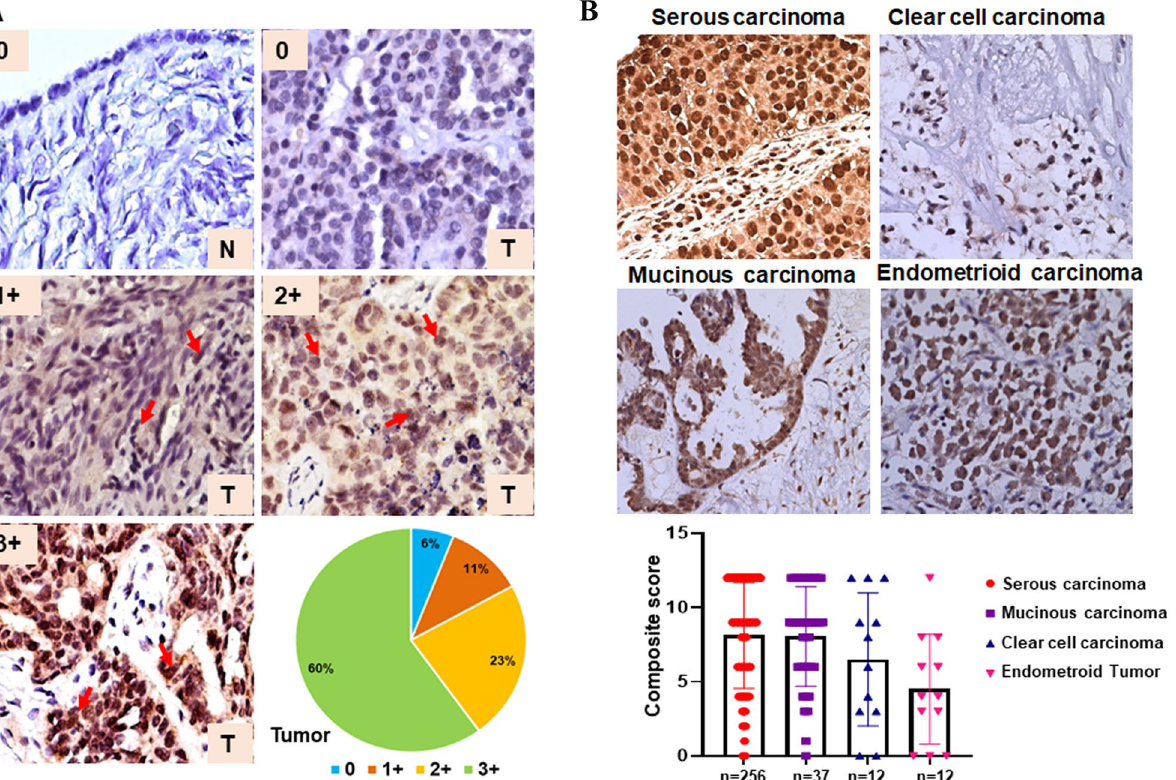
Figure 1. MYB protein expression in the cohort of ovarian cancer. ( A ) MYB expression in normal (N) ovary (n = 23) and tumor (T) samples (n = 373) was determined by performing immunohistochemistry. MYB staining was predominantly observed in the nucleus (arrow) with diffuse staining in the cytoplasm. Overall staining intensity ranged from 0- to 3 + in OC cases, whereas none of the normal ovary tissue sections exhibited a positive MYB staining. ( B ) A variable expression of MYB was observed in different histological subtypes of ovarian cancer (serous carcinoma, SC; mucinous carcinoma, MC; clear cell carcinoma, CCC and endometrioid carcinoma, EC). The bar diagram shows the distribution of composite score (nuclear MYB staining intensity and percent positivity) in histological subtypes of epithelial ovarian cancer. Magnification ×200.